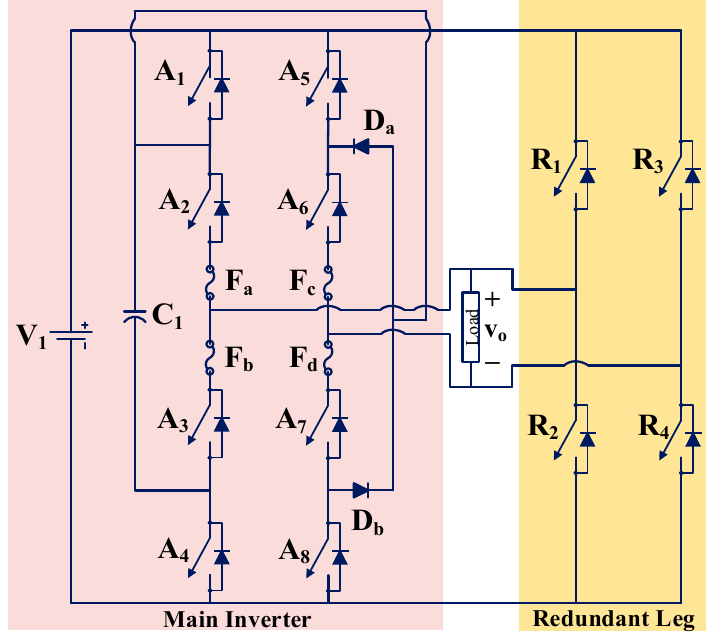
Figure 11. Single-phase five-level FT MLI (TP11) [51].